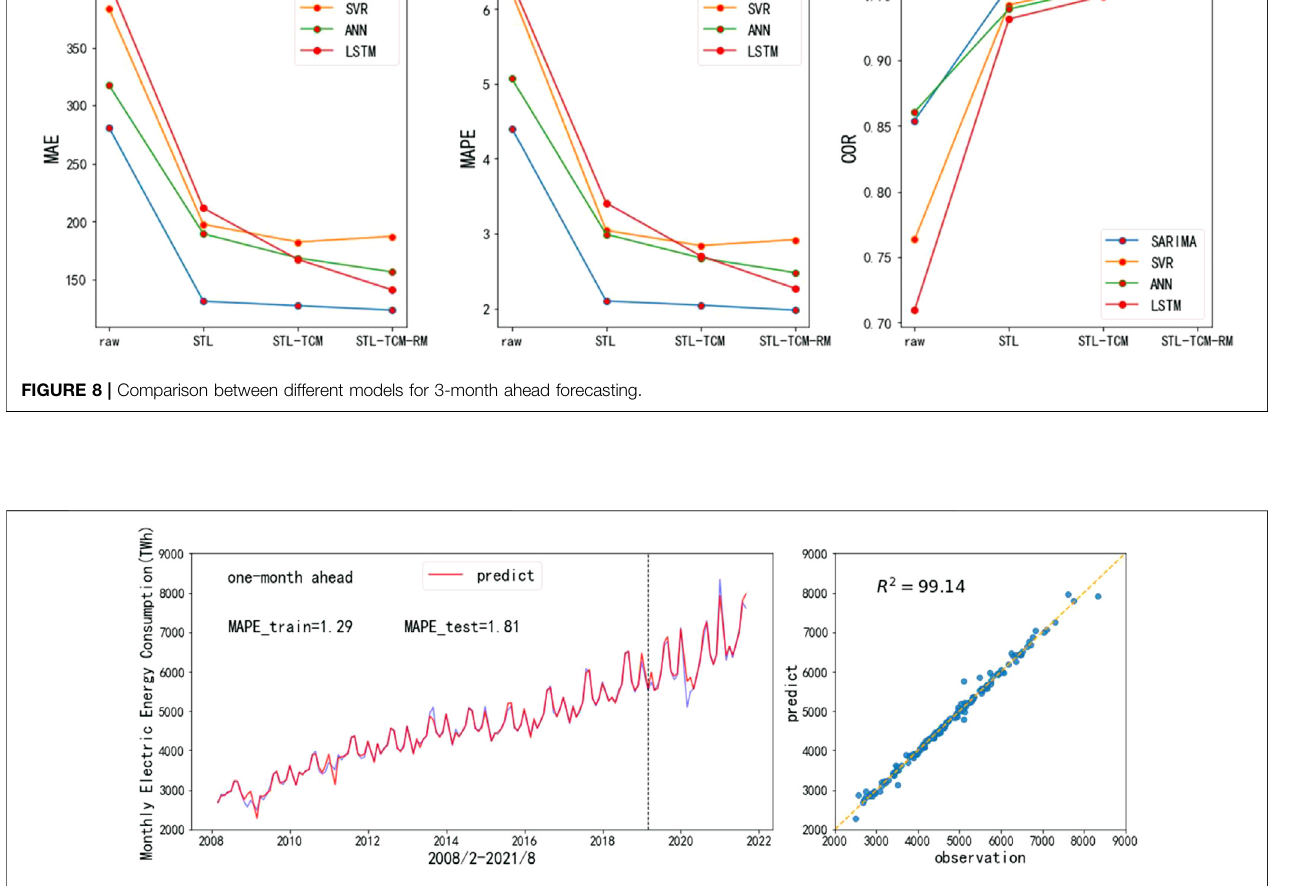
FIGURE 9 | STL-SARIMA – time correlation modi fi cation (TCM) – residual modi fi cation (RM) for 1-month ahead forecasting.